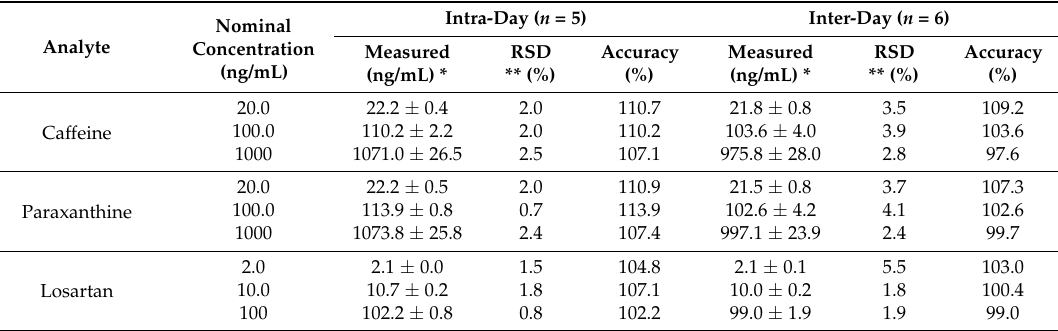
Table 3. Intra- and inter-day precision and accuracy of quality control (QC) samples for all probe drugs and their metabolites in human